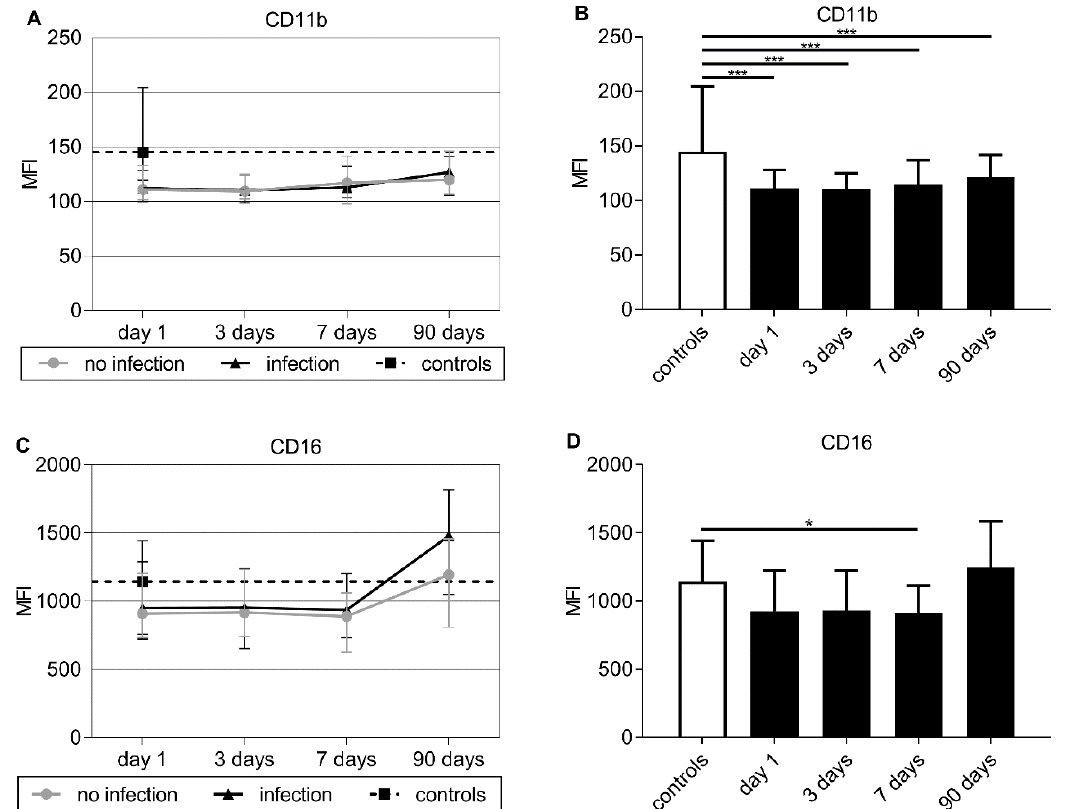
Figure 4. ( A , C ) Time course of CD11b and CD16 expression levels on neutrophils for patients without infection (dot), patients with infection (triangle), and controls (black square). For better comparison the control level is plotted as a dotted line over the entire time course. There were no significant results in day-by-day group comparison by Mann–Whitney U testing. ( B , D ) Time course of CD11b and CD16 expression on cell surface of neutrophils for all stroke patients (black bars) and control levels (white bars). Given are group medians and upper interquartile ranges. Testing was performed using Mann–Whitney U test for comparing receptor expression on neutrophils between all stroke patients and control levels. Significant results are marked as * for p < 0.05, ** for p < 0.01, and *** for p < 0.001.